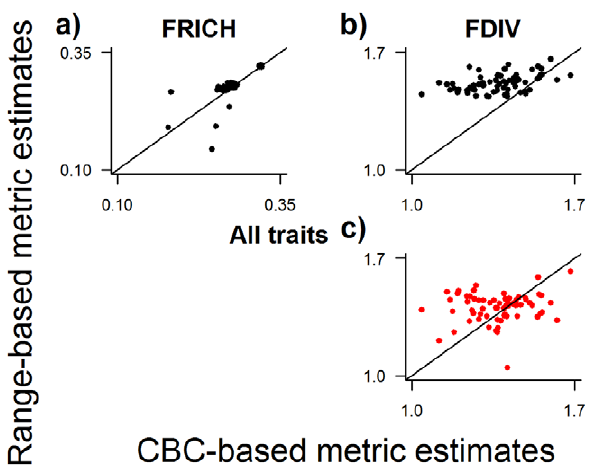
Figure 5. Correlation between distribution-based and CBC- based values of community composition metrics based on all traits together. Maps were generated of functional richness (FRICH; a) and functional divergence (FDIV; b, c). Functional divergence was measured using the Rao index. Observed values were calculated from recorded abundances at 68 evaluation Christmas Bird Count (CBC) sites. Distribution-based estimates of the metrics were generated using four methods, with the best two shown here, as in Fig. 3. Lines represent y=x. Full results for all four methods are presented in Table 1.